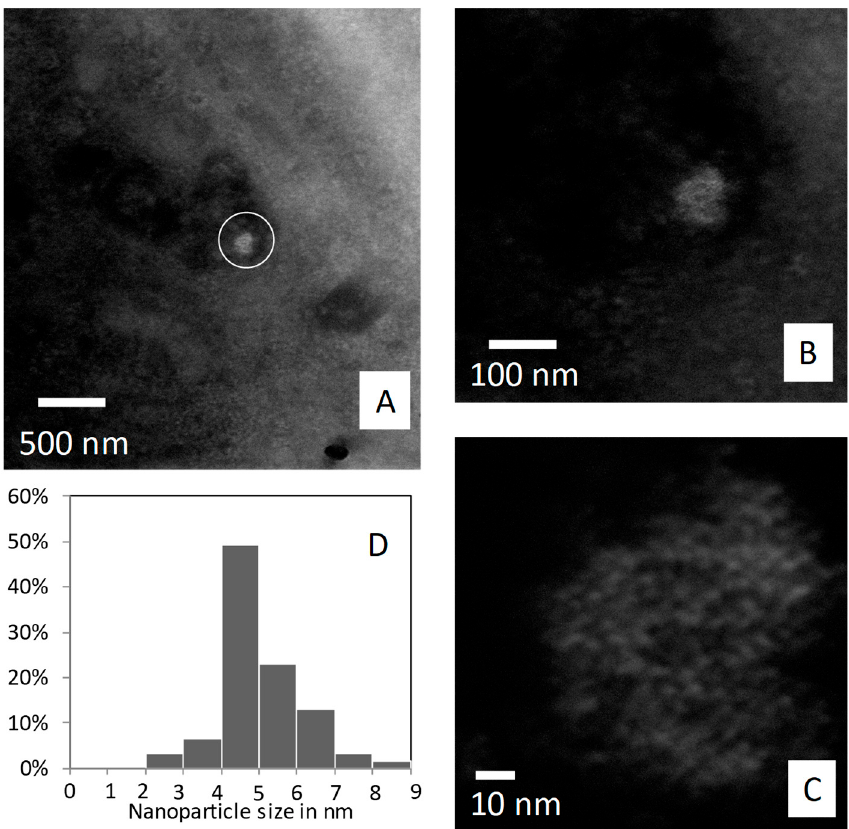
Figure 5. High-angle annular dark-field scanning transmission electron microscopy (HAADF-STEM) images. ( A ) Overall view of U87 MG cells containing Au@DTDTPA. The circle indicates a bright object containing atoms with a high atomic number that correspond to Au@DTDTPA. ( B , C ) High resolution images of the area in the circle of image A. ( D ) Size distribution of the bright object in the area in the circle of image A.